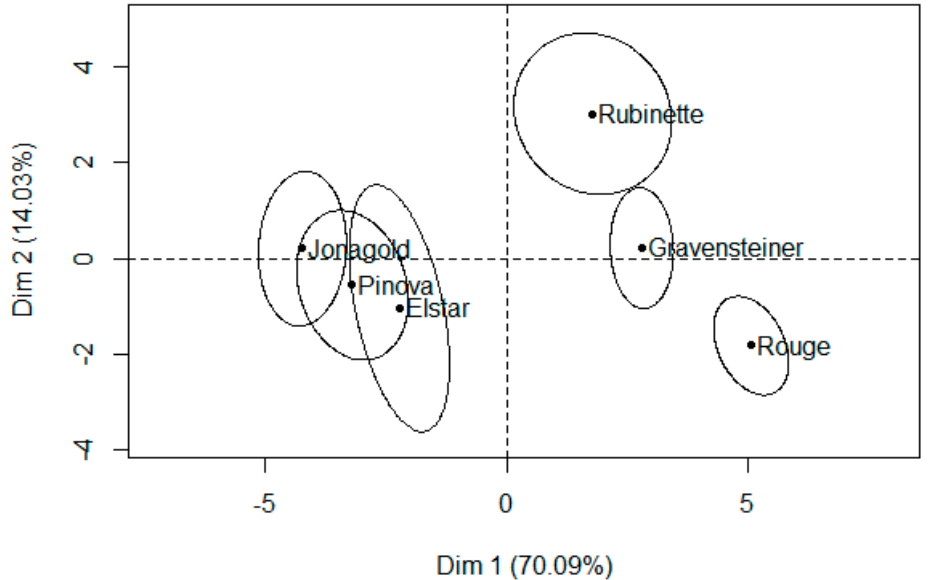
Figure 7. Dimension 1 (Dim 1) and Dimension 2 (Dim 2) of the multiple factor analysis individual plot of apple juice samples and confidence ellipses.